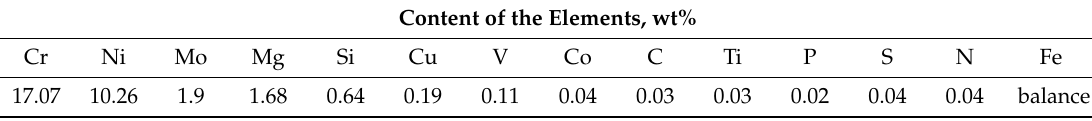
Figure 1. The optical images of samples: ( a ) as received; and ( b ) mechanically grounded. Table 2. Chemical composition of AISI 316L (cathode in PEO